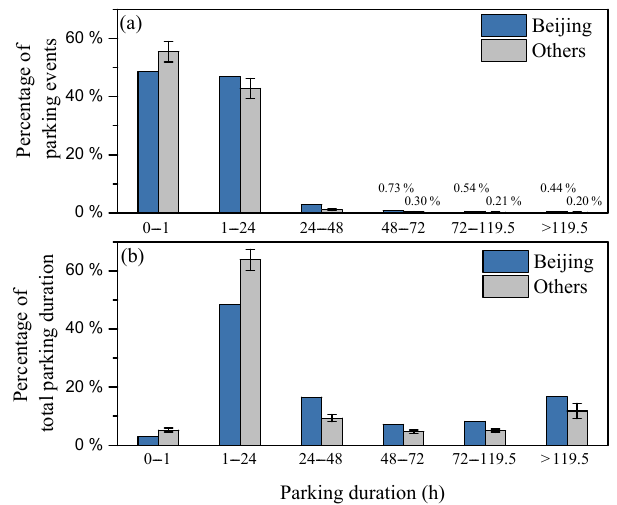
Figure 3. Real-world parking duration distribution: (a) percentage of parking events; (b) percentage of total parking duration.